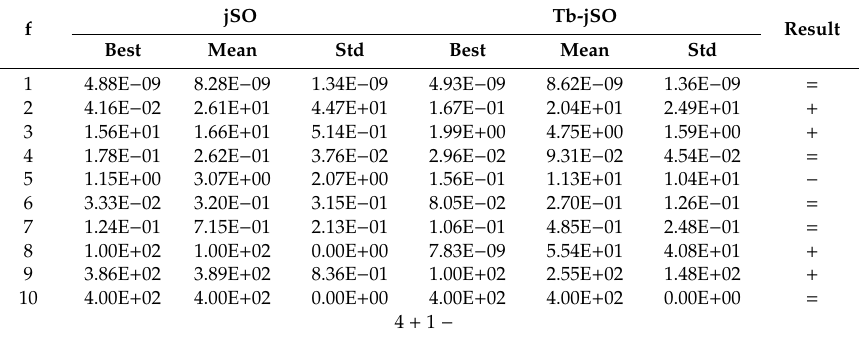
Table 17. jSO vs. Tb-jSO on CEC2020 in 15 D .